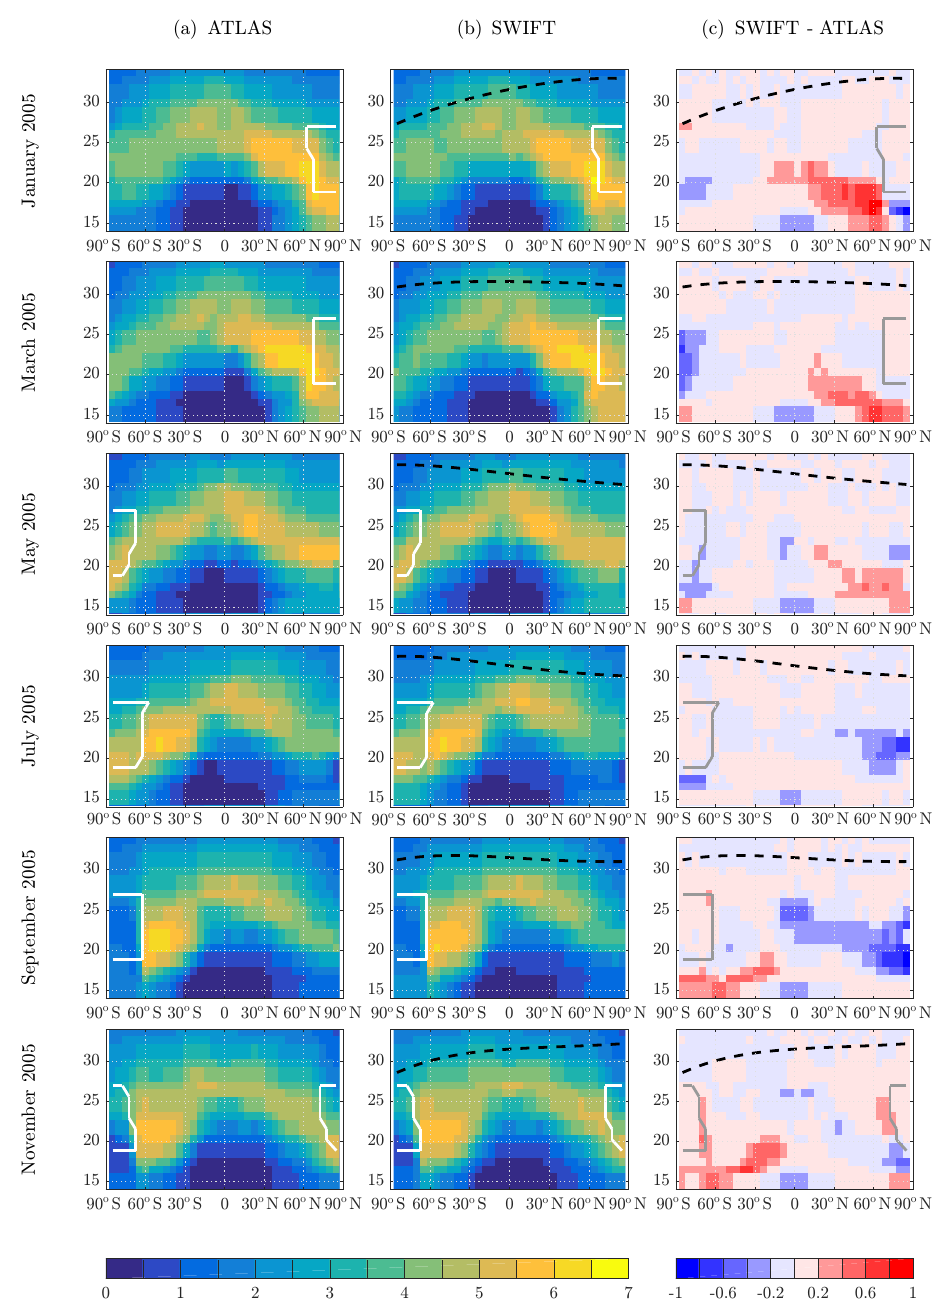
Figure 5. The 2005 zonal and monthly mean stratospheric ozone concentrations plotted in equivalent latitude vs. pressure altitude. (a) Ref- erence simulation with ATLAS, (b) the SWIFT simulation and (c) the difference. The dashed black contour shows the upper boundary of the (cid:49) O x regime. The white contour indicates the location of the polar vortices.